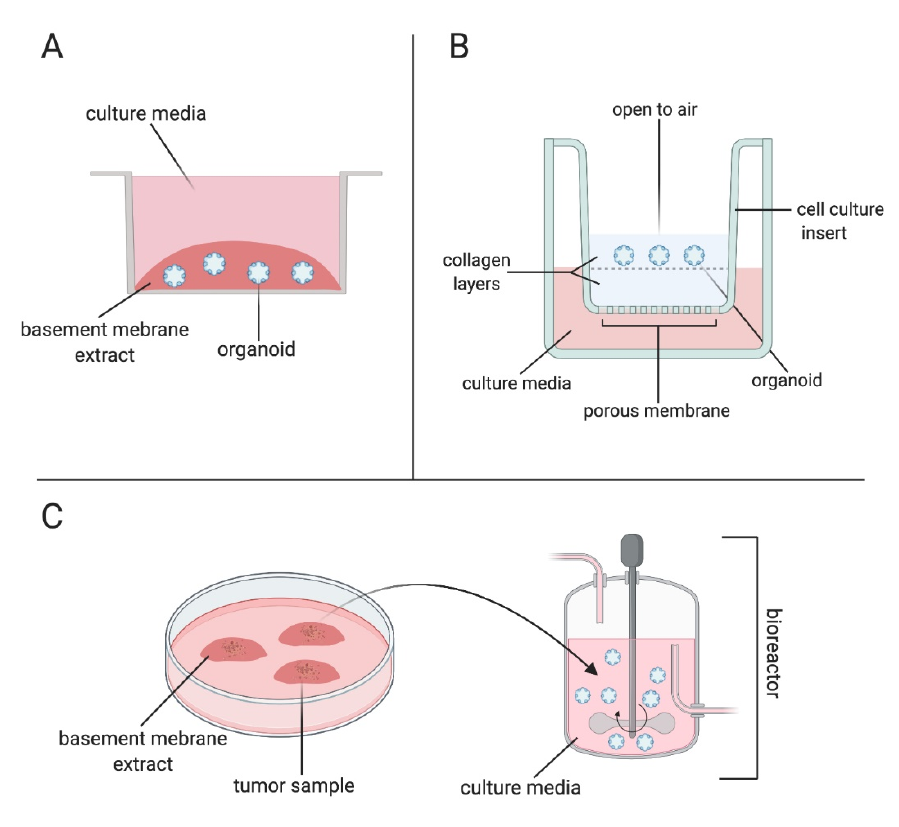
Figure 1. Methods of organoid culture. ( A ) Organoids can be cultured in the submerged method by disrupting tissue mechanically and enzymatically into single-cell suspensions, followed by embedding them in basement membrane extract (BME) and submerging in the culture media. ( B ) In the air–liquid interface (ALI) method, tissue is minced into smaller fragments and embedded in a layer of collagen, which is assembled in a cell culture insert that has a layer of acellular collagen. The cell culture insert is placed in a culture dish with media. ( C ) Alternatively, tissue fragments can be embedded in BME and followed by transferring into a bioreactor.